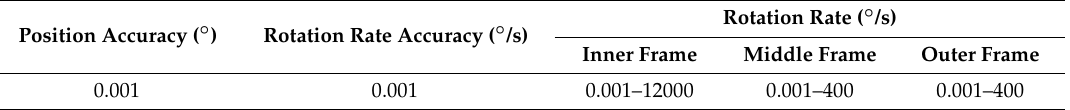
Table 2. Technical parameters of tri-axial flight simulator.